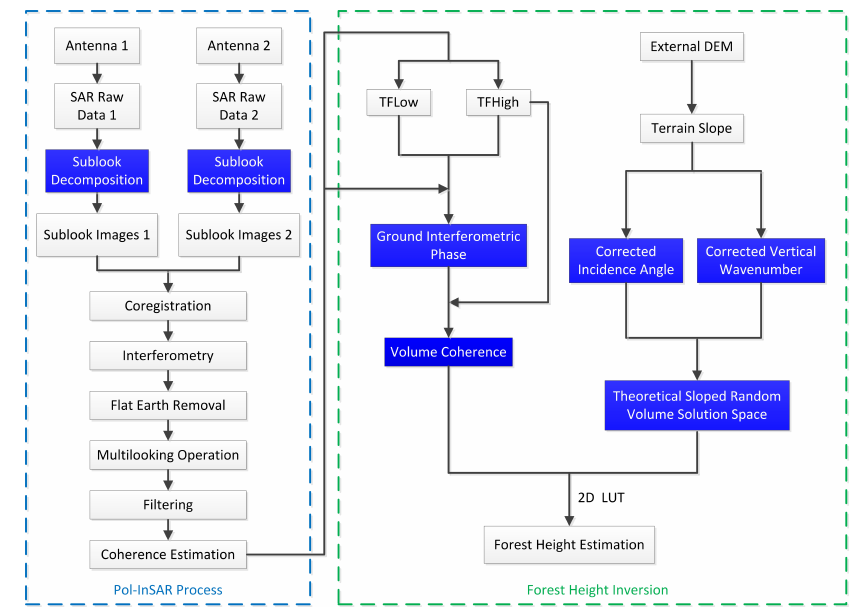
Figure 6. The flowchart of the S-RVoG model inversion based on the time-frequency optimization.